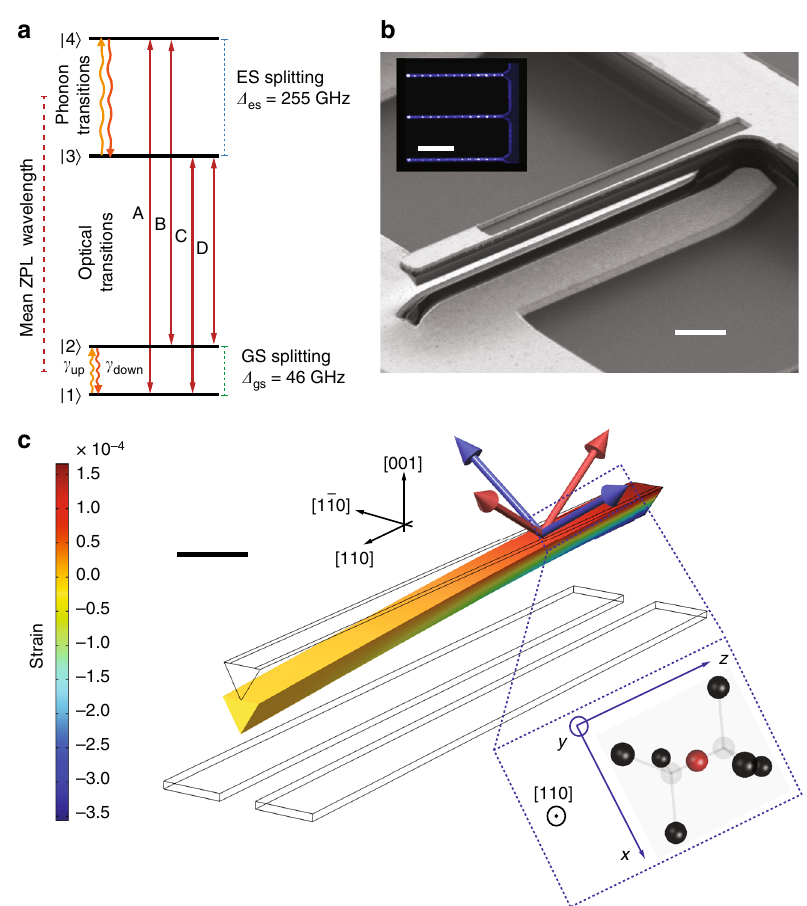
Fig. 1 Description of the SiV − and NEMS system. a Electronic level structure of the SiV − showing the mean zero phonon line (ZPL) wavelength, frequency splittings between orbital branches in the ground state (GS) and excited state (ES) ( Δ gs and Δ es , respectively) at zero strain, and the four optical transitions A, B, C, and D. Also shown are single-phonon transitions in the GS and ES manifolds. b Scanning electron microscope (SEM) image of a representative diamond NEMS cantilever. Dark regions correspond to diamond, and light regions correspond to metal electrodes. Scale bar corresponds to 2 μ m. (Inset) Confocal photoluminescence image of three adjacent cantilevers. The array of bright spots in each cantilever is fl uorescence from SiV − centres. Inset scale bar corresponds to 10 μ m. c Simulation of the displacement of the cantilever due to the application of a DC voltage of 200 V between the top and bottom electrodes. The component of the strain tensor along the long axis of the cantilever is displayed using the colour scale. Scale bar corresponds to 2 μ m. Crystal axes of diamond are indicated in relation to the geometry of the cantilever. Arrows on top of the cantilever indicate the highest symmetry axes of four possible SiV − orientations, and their colour indicates separation into two distinct classes upon application of strain. SiV − centres studied in this work are shown by blue arrows and are oriented along ½ 111 (cid:3) , ½ 111 (cid:3) directions. They are orthogonal to the cantilever long-axis, and experience strain predominantly in the plane normal to their highest symmetry axis. Inset shows the molecular structure of such a transverse-orientation SiV − along with its internal axes, when viewed in the plane normal to the [110]